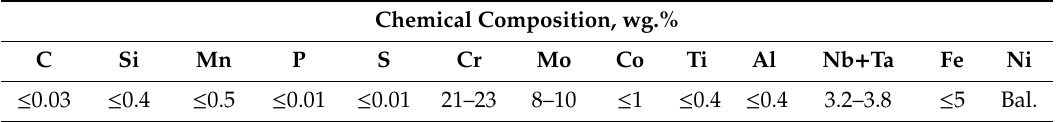
Table 3. Chemical composition of Inconel 625 superalloy; Böhler L625 (EN NiCr22Mo9Nb) powder according to manufacturer data (voestalpine Böhler Surfacing Germany GmbH, Hamm, Germany). Chemical Composition, wg.%